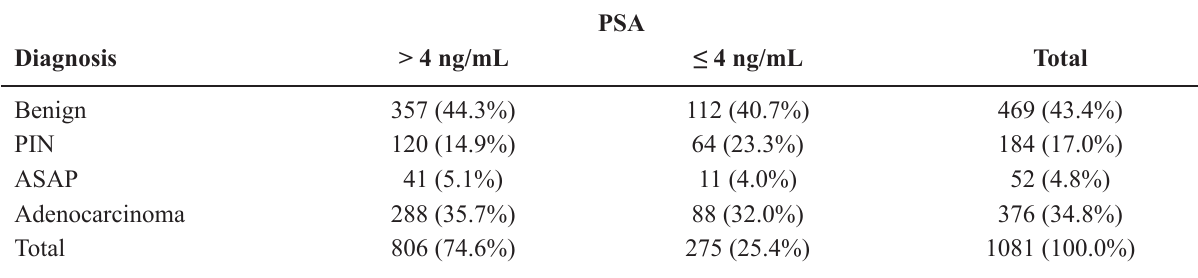
Table 2 – Diagnosis of prostate biopsy in 1081 patients with PSA ≤ 4 ng/mL and PSA > 4